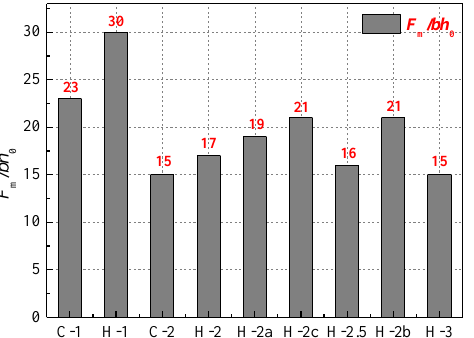
Figure 7. Ratio of the peak load to the cross-sectional